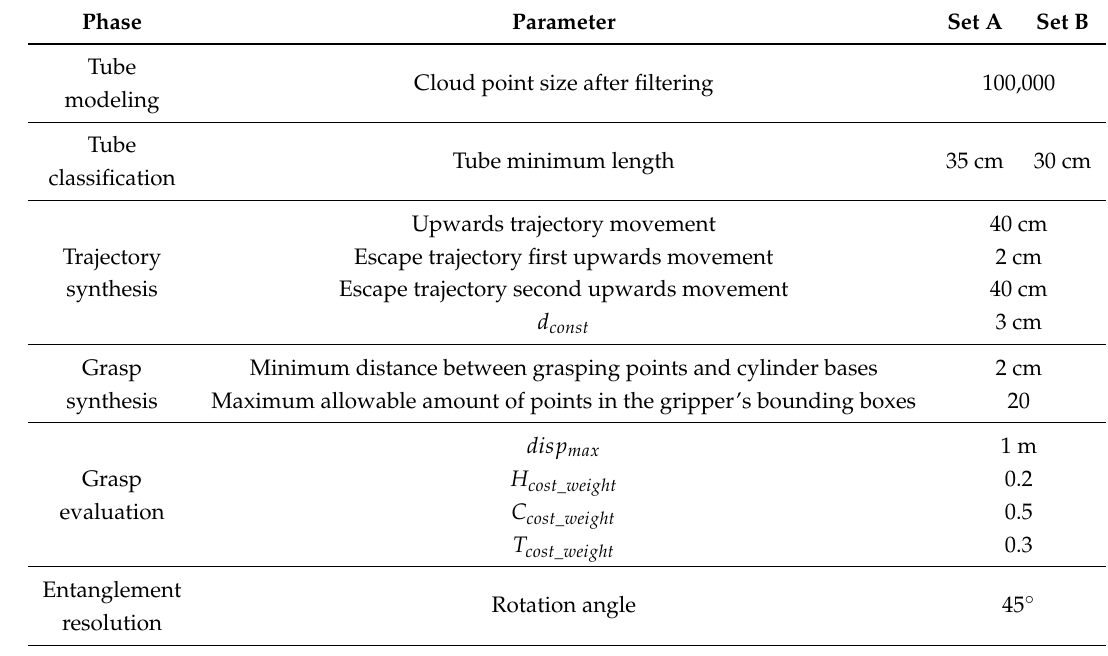
Table 2. Parameter values used in the experiments.